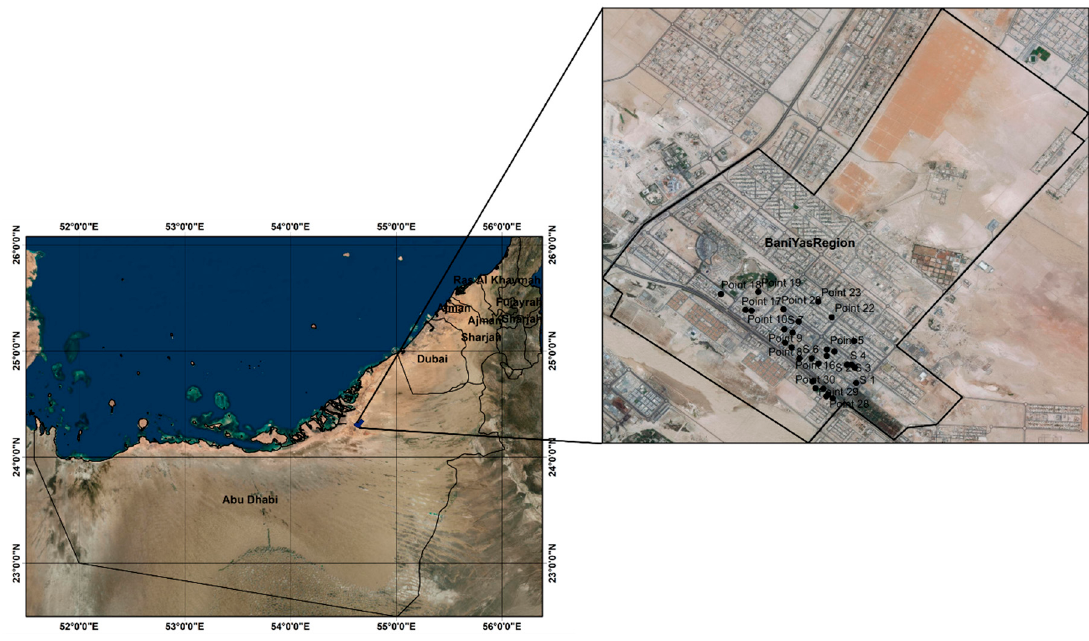
Figure 1. Sampling locations and study area.